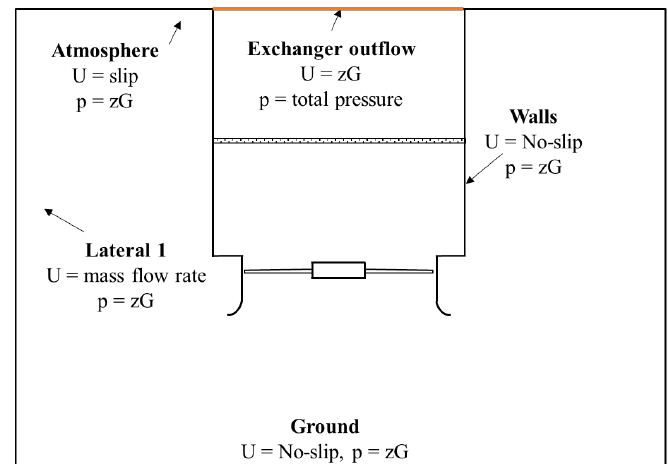
Figure 7. Scheme of boundary conditions, front view.